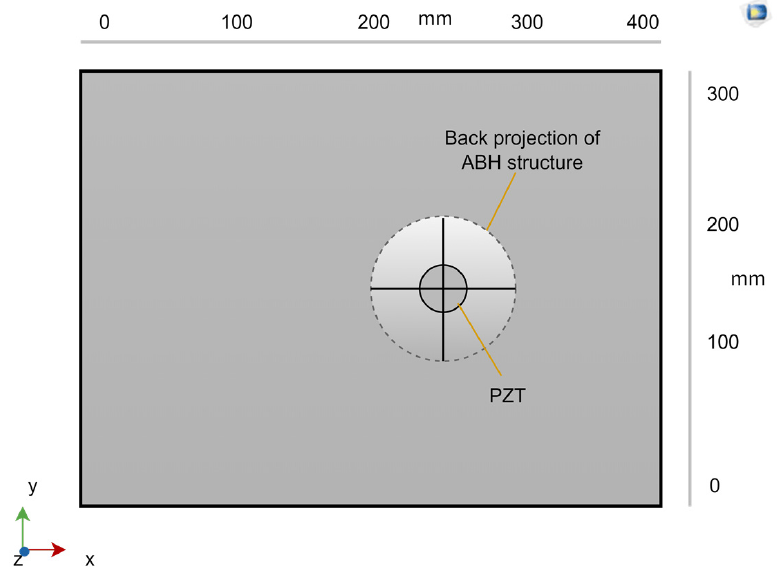
Figure 4. ABH board with PZT on the back.